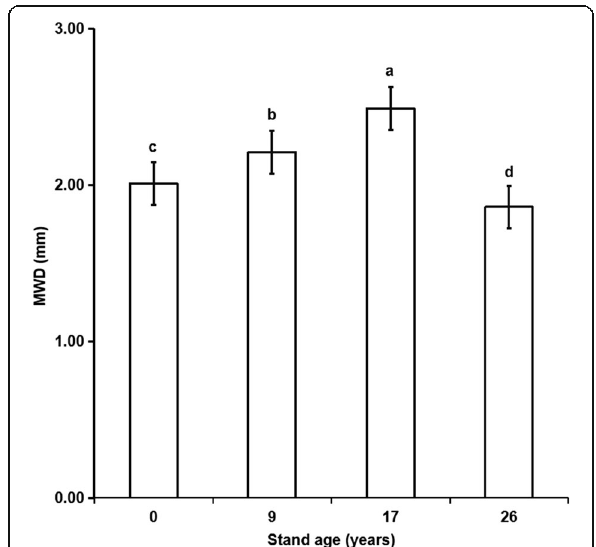
Fig. 2 Soil aggregate stability (as indicated by the MWD) in the Chinese fir plantations with different stand ages (0, 9, 17, and 26 years old). Data represent the average of 3 replicates and error bars represent the standard errors. Different lowercase letters indicate significant differences among the different stand ages. MWD, mean weight diameter